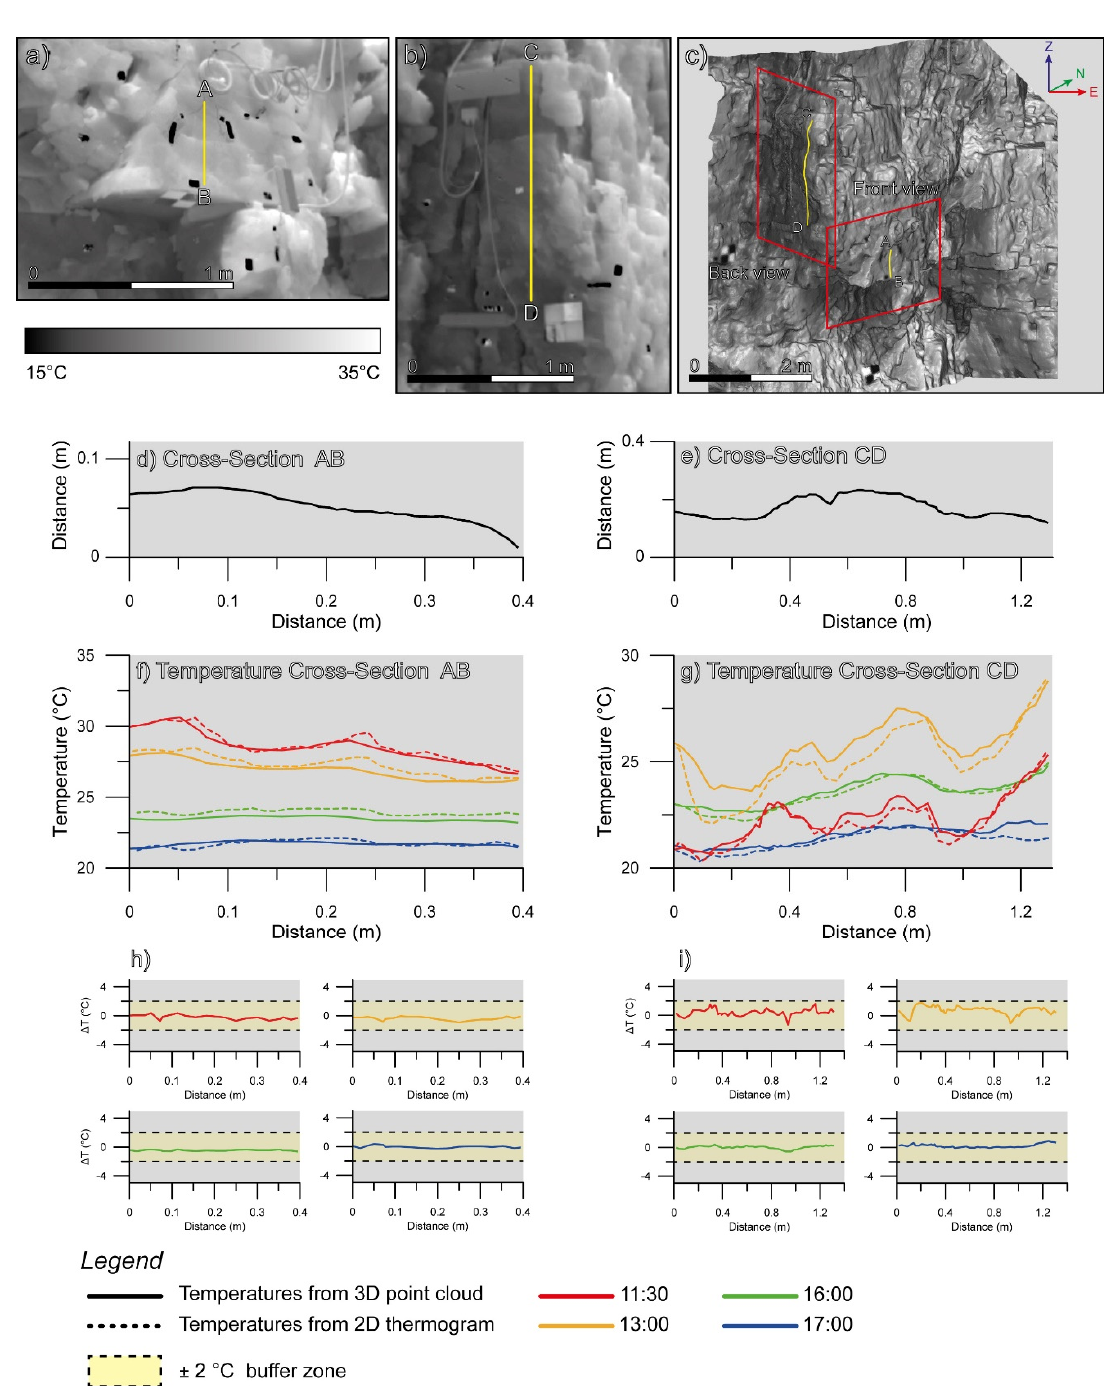
Figure 8. ( a , b ) Results of the comparative analysis between temperatures extracted from 2D thermograms and ( c ) 3D TIR point clouds for the spring survey. ( d , e ) Surface profiles from which temperatures were extracted (AB and CD) are marked both in 2D thermograms and for an example of a 3D point cloud visualization. None of the two profiles intercept any instrumental device of the monitoring system. ( f , g ) Absolute temperature values are plotted against the length of the respective section for 3D and 2D data. For each analyzed section and for every acquisition, the difference between absolute temperature values ( ∆ T) was computed ( h —section AB, i —section CD). A ± 2 ◦ C buffer zone, representing the calibrated temperature accuracy of the IR camera, is also highlighted (yellow